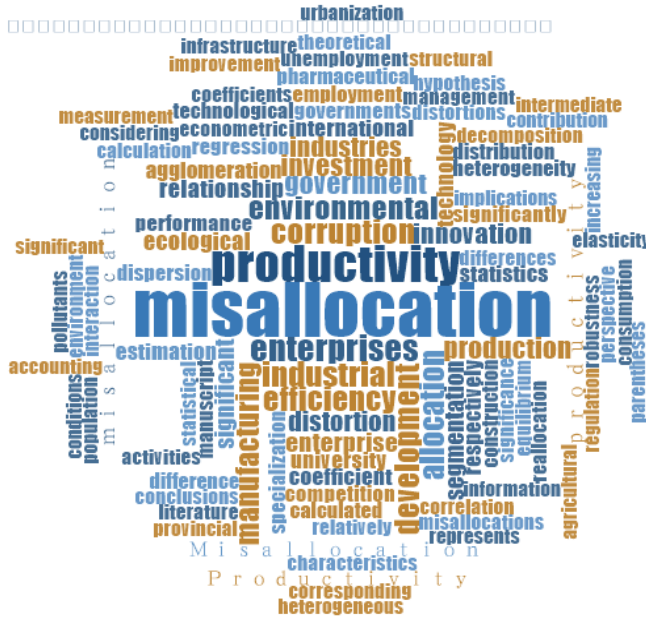
Figure 7. Word cloud for the 2016–2020 research papers.